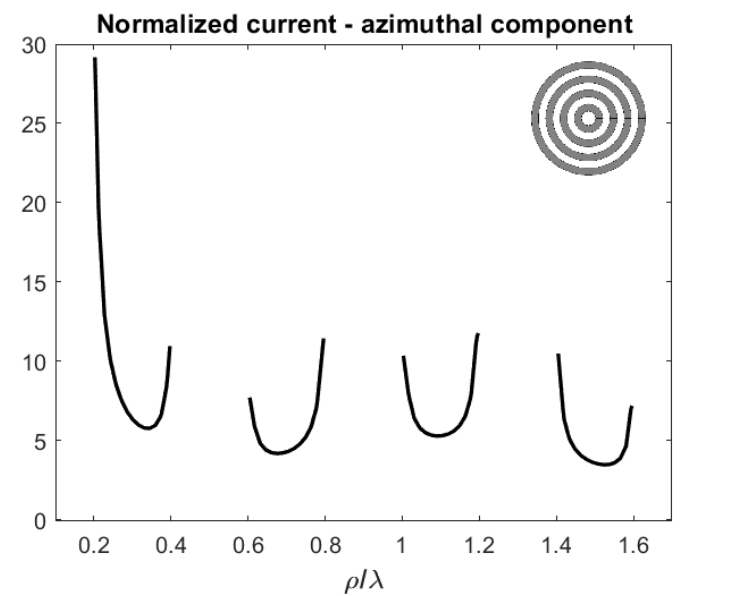
Figure 6. Behavior of the azimuthal component of the current density for the geometry #2 of Table 1 (sketched in the inset) for an incidence angle θ inc = 0 ◦ .